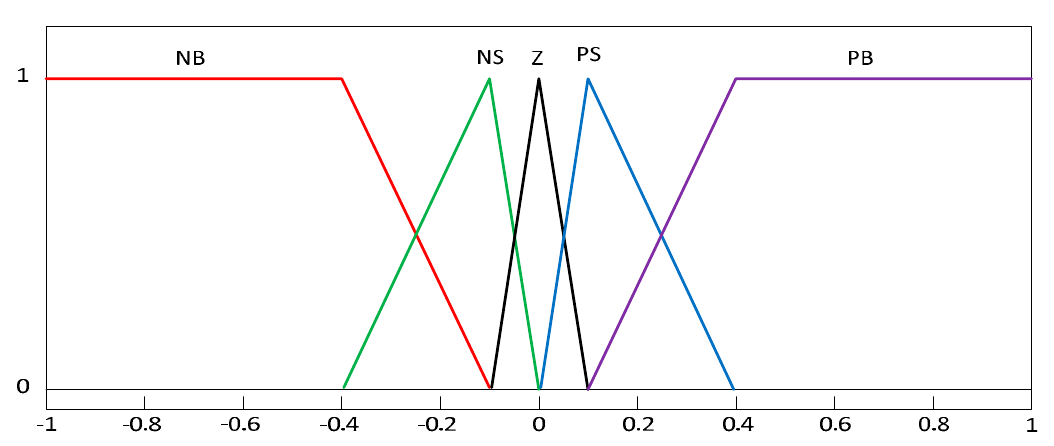
Figure 3. Schematic of membership functions (MFs) for inputs and outputs.